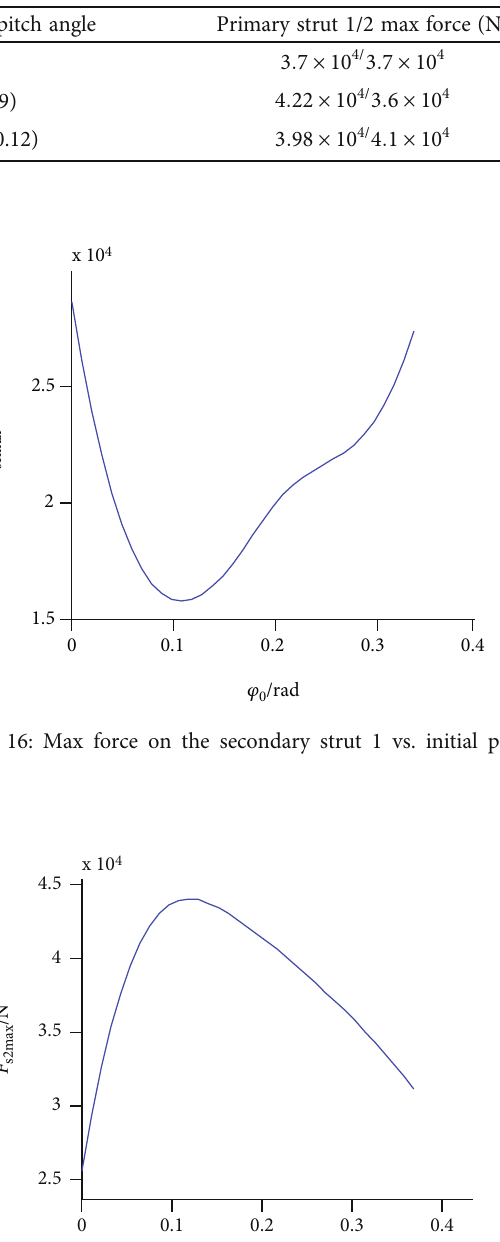
Table 10: Impact of typical working conditions of initial pitch angle on maximum force of primary